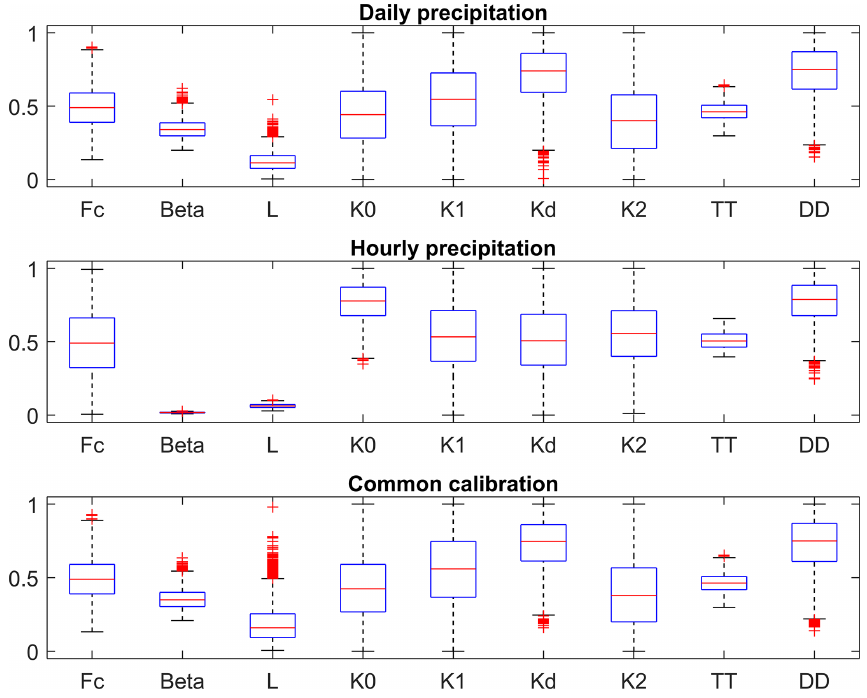
Figure 15. Comparison of model parameters for different temporal resolutions for Rottweil catchment.